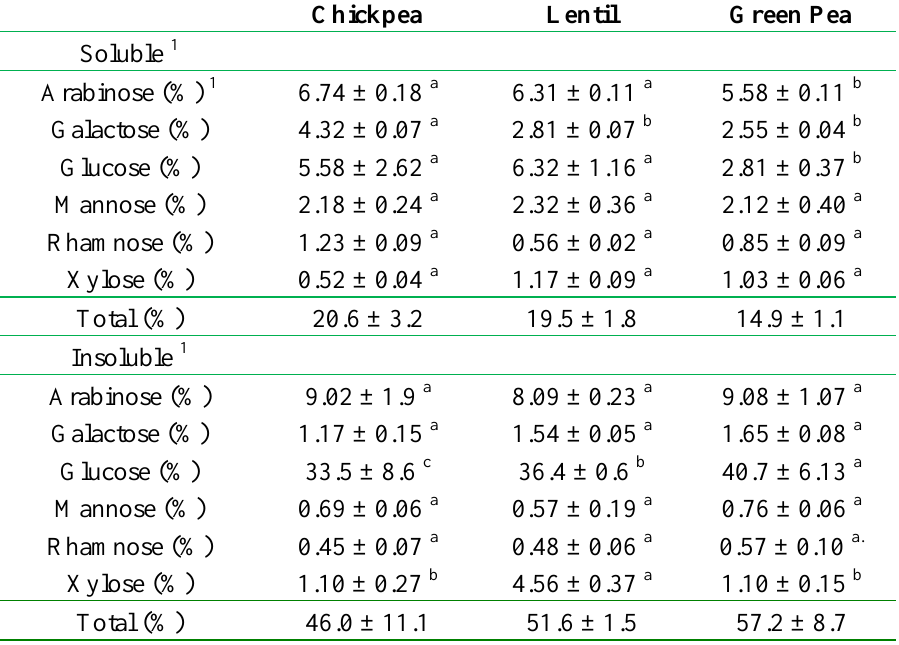
Table 4. Neutral sugar distribution in the soluble and insoluble fibre fractions calculated as a percentage of total carbohydrates.